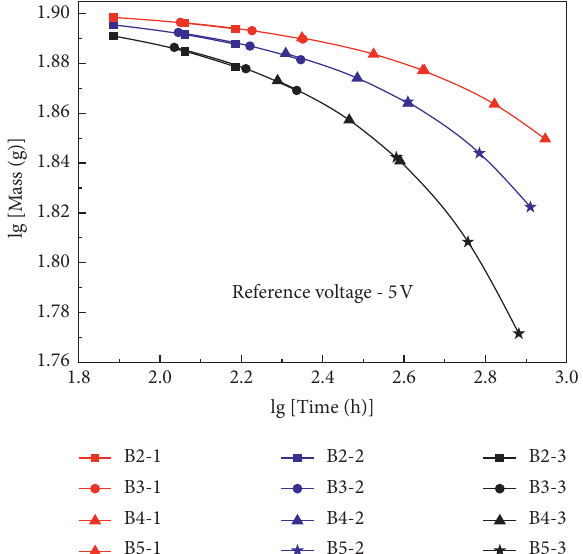
Figure 8: Time-residual mass curve of specimens shifted with respect to the reference curve for the applied voltage of